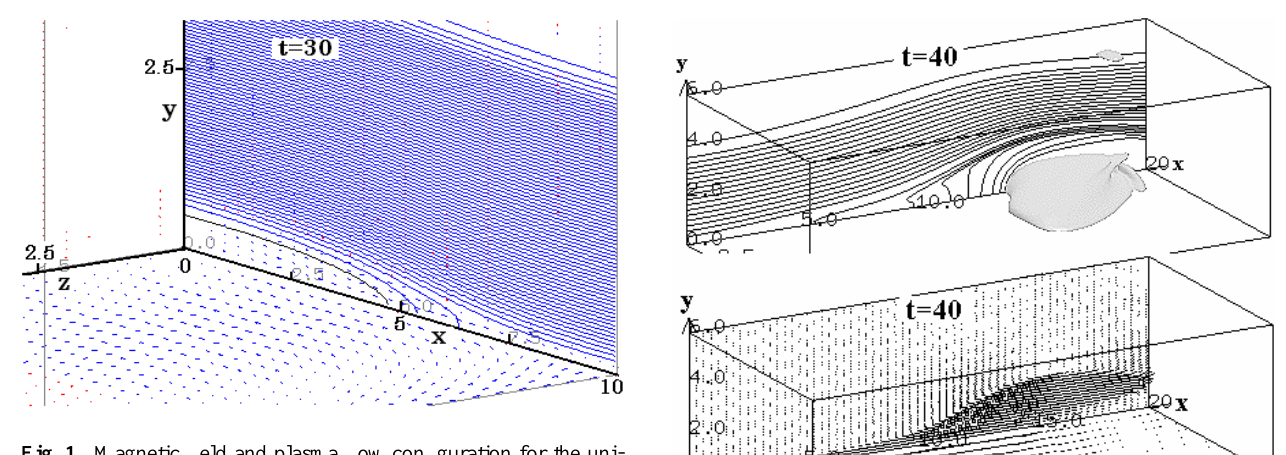
Fig. 1. Magnetic field and plasma flow configuration for the uni- form resistivity model with η = 0 . 001.